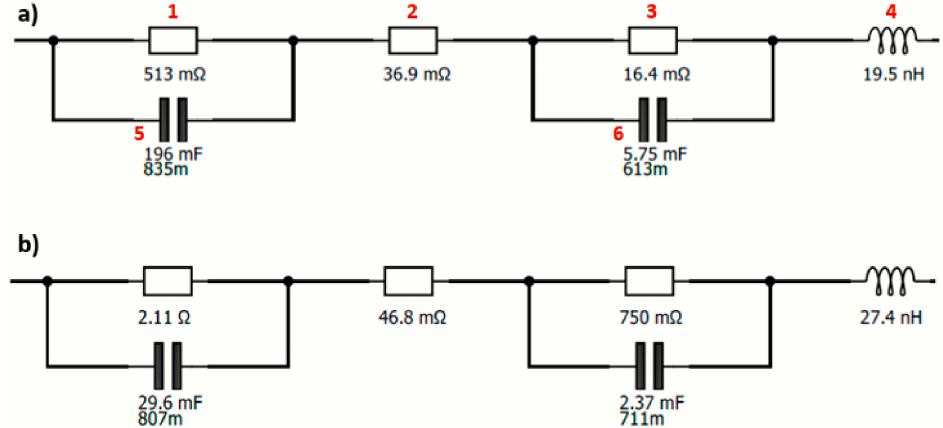
Figure 10. EEC at 1.445 V for the ( a ) Pt/CB and Ir black membrane and ( b ) 50% FeP/CB and Ir black membrane.